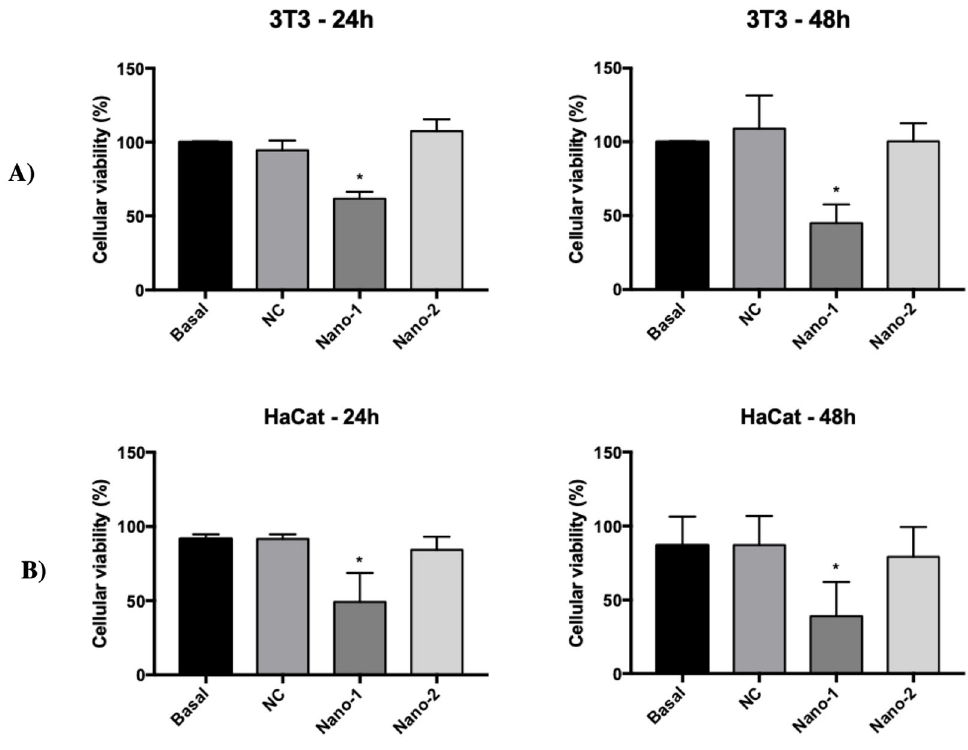
Figure 2. Viability of NIH-3T3 fibroblasts ( A ) and HaCat keratinocytes ( B ) after 24 h and 48 h incubation with nanoemulsions at 10 12 particles/mL. Results were statistically analyzed using ANOVA, followed by Tukey’s test. (*) indicates statistically significant difference with P < 0.05 (n = 3 determinations).